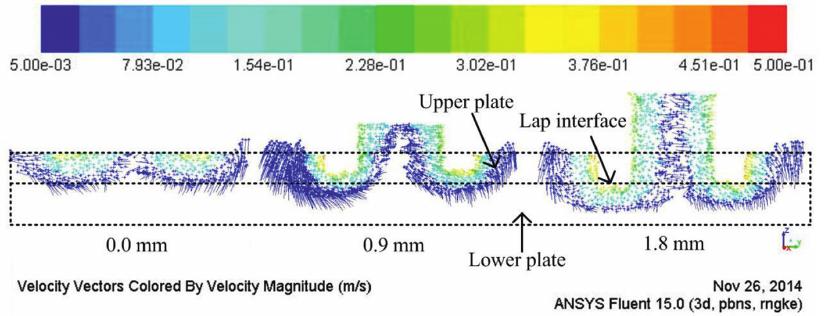
Figure 13: High-speed areas using different sleeve plunge